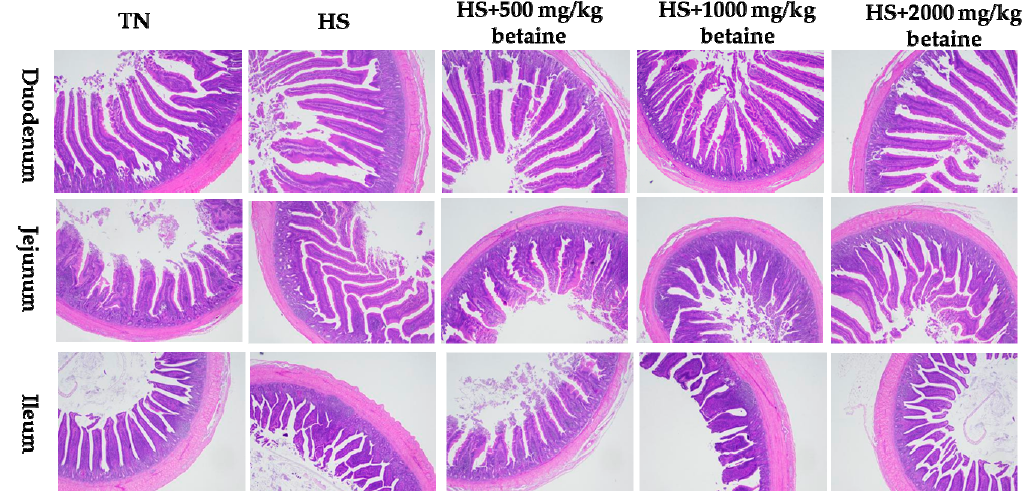
Figure 2. Photomicrographs of the effects of dietary betaine on intestinal morphology of yellow-feathered broilers after 10 weeks of heat stress (Stained with hematoxylin and eosin; TN, thermoneutral zone; HS, heat stress).